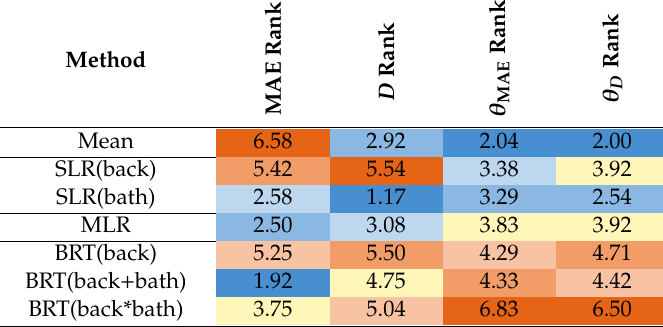
Table 4. Performance comparison of bulk shift methods at harmonizing datasets of di ff erent frequency for Bedford Basin and Patricia Bay datasets. Scores are average ranks for all frequencies and both datasets, relative to the other methods. Ranks are colour-coded from blue to orange for best to